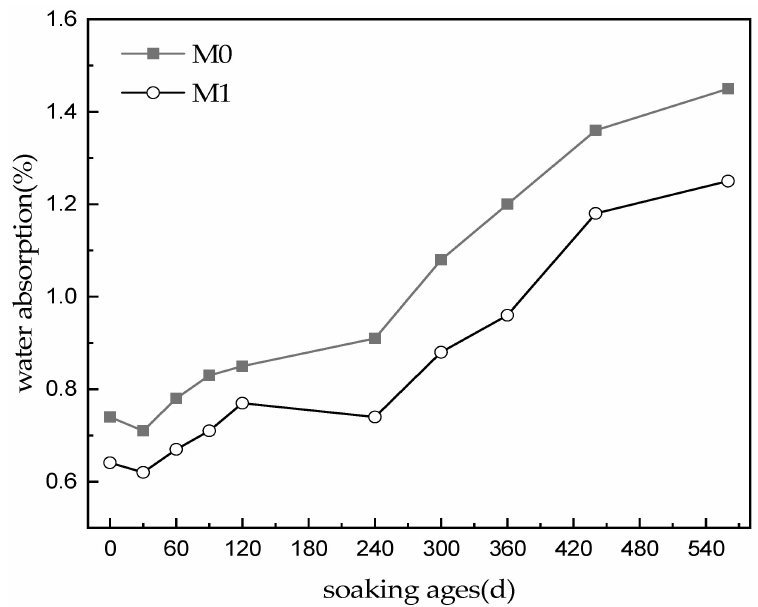
Figure 3. Water absorption of MKPC specimens with immersion time.